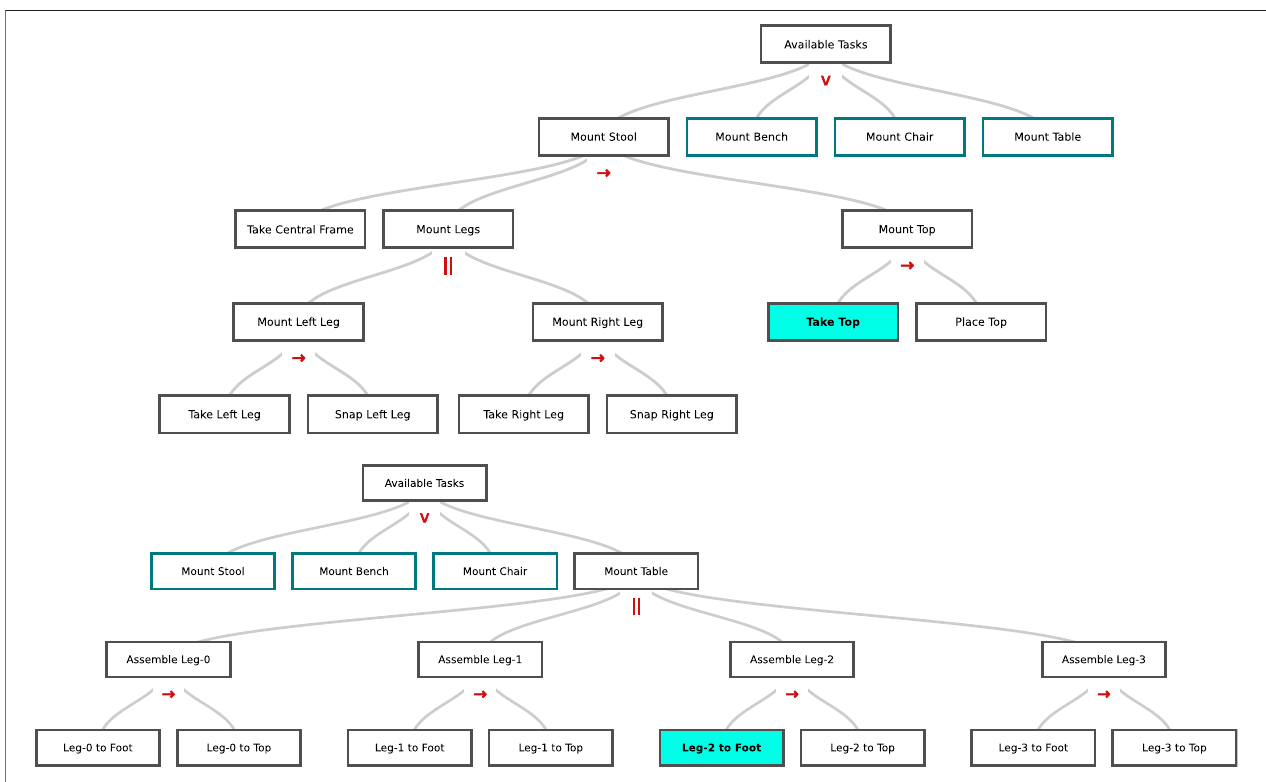
FIGURE 1 | Example HTMs for human-robot assembly tasks. The user can retrieve information on the task execution, and inquire the system about task progressionthat willbe highlighted bytherobot during execution (cyan blockin picture). Theoperator type betweensubtasks ( → forsequential tasks, (cid:1) forparalleltasks, ∨ for alternative tasks) is also available for the user to inspect. (A) HTM used in Roncone et al. (2017). (B) HTM used in this work. See Section 5.2 for details.